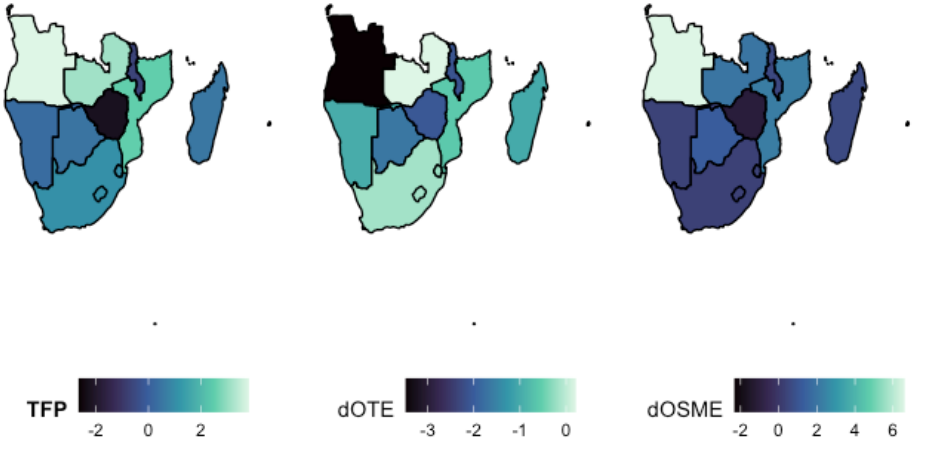
Figure 5. Agricultural productivity growth in Southern Africa as shown by TFP and components of TFPE, 2000–2016. Note: dTFP = Productivity Change, dOTE = Technical Efficiency Change and dOSME = Scale-Mix